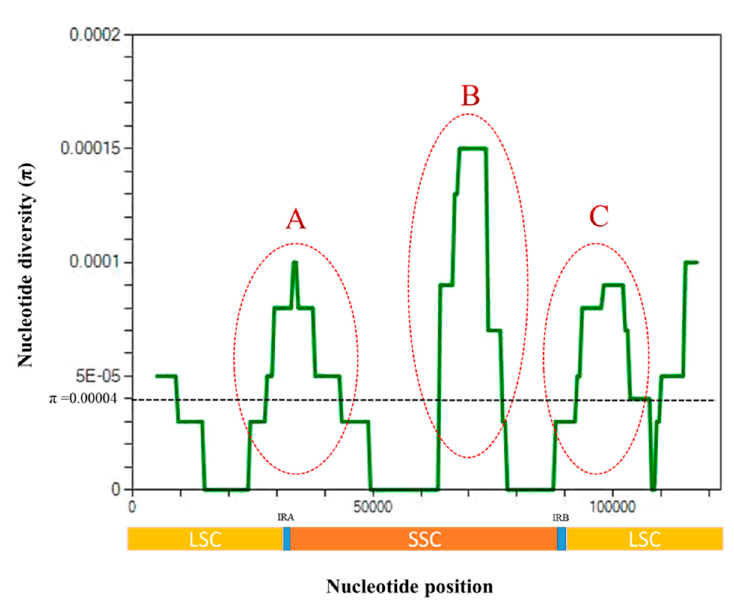
Figure 4. The nucleotide diversity ( π ) of Japanese larch chloroplast genomes, based on sliding window analysis.